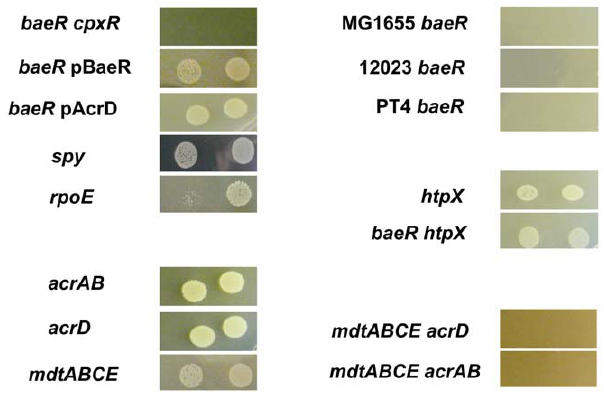
Figure 6.Tungstate sensitivity of baeR mutants in E.coli and Salmonella and of different Salmonella Typhimurium SL1344 mutants. Two concentrations of cells were spotted on LB agar plates containing 30mM of sodium tungstate and grown at 37 u C overnight. MG1655 is an E. coli strain, 12023 is a Salmonella Typhimurium strain and PT4 is a Salmonella Enteritidis strain (see Table S1).